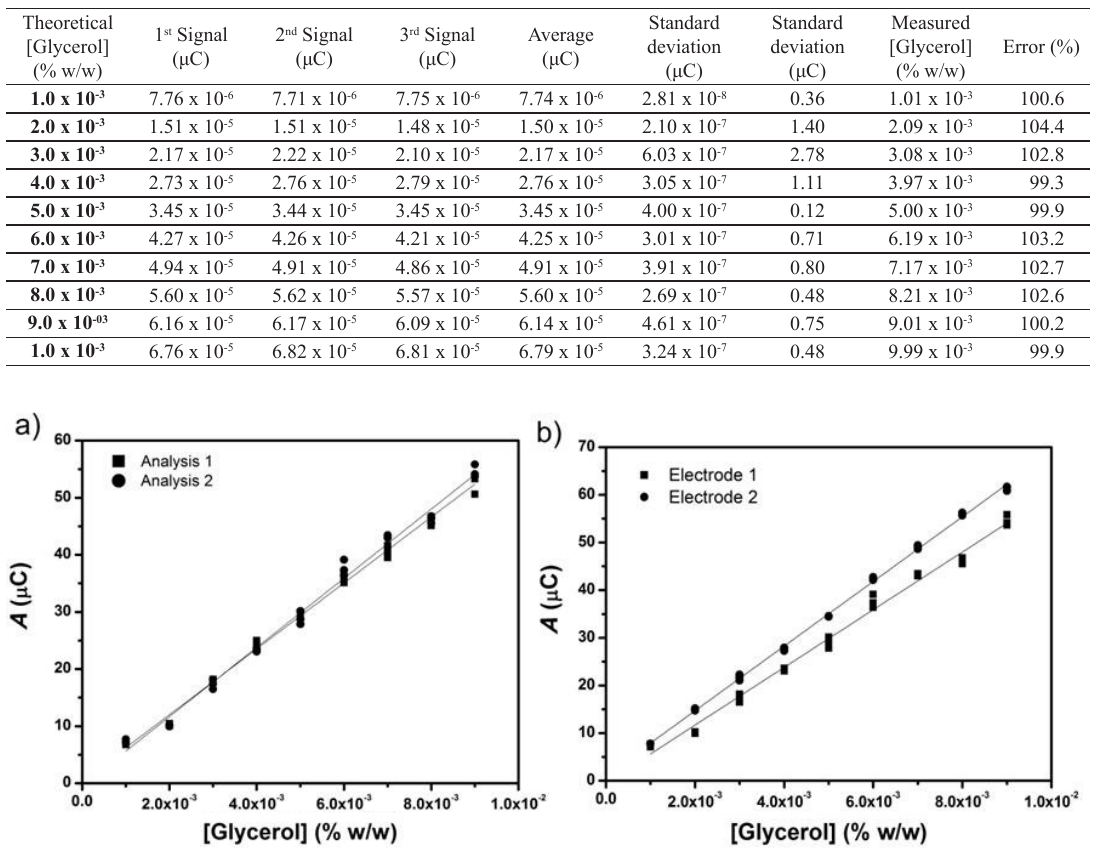
Figure 7. Analytical curves obtained by the same analyst using the same GCE-ErGO-EAuNp on different days (a) and analytical curves obtained by the same analyst using different GCE-ErGO-EAuNp